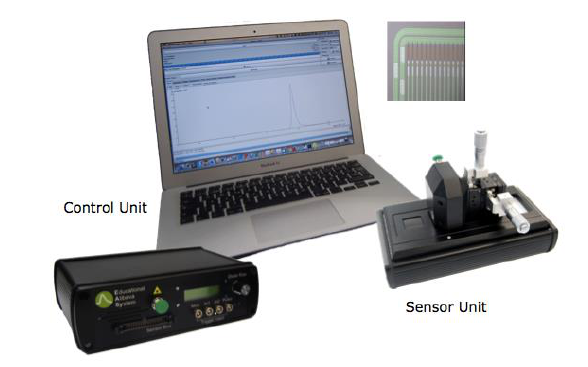
Fig . 1. EASY system with the Control Unit, the Sensor Unit and the acquisition program Alibava-gui running in the